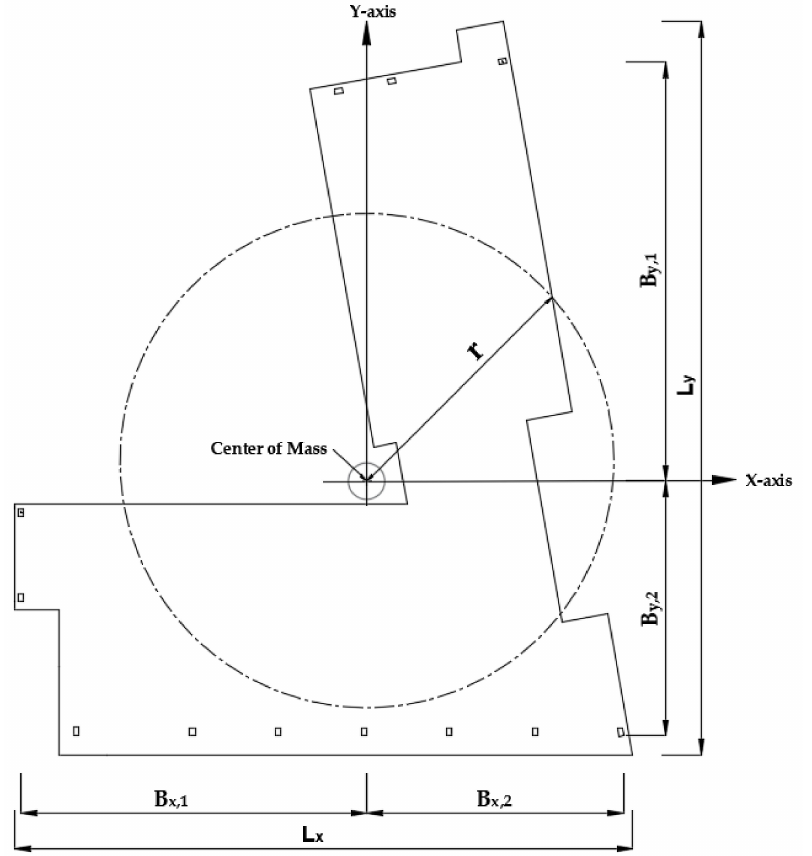
Figure 1. The radius of gyration ( r ) and distance between the centre of mass (CM) and furthest structural elements ( B x, 1 , B x, 2 , B y, 1 , and B y, 2 ) about the two principal directions (x and y) in the irregular